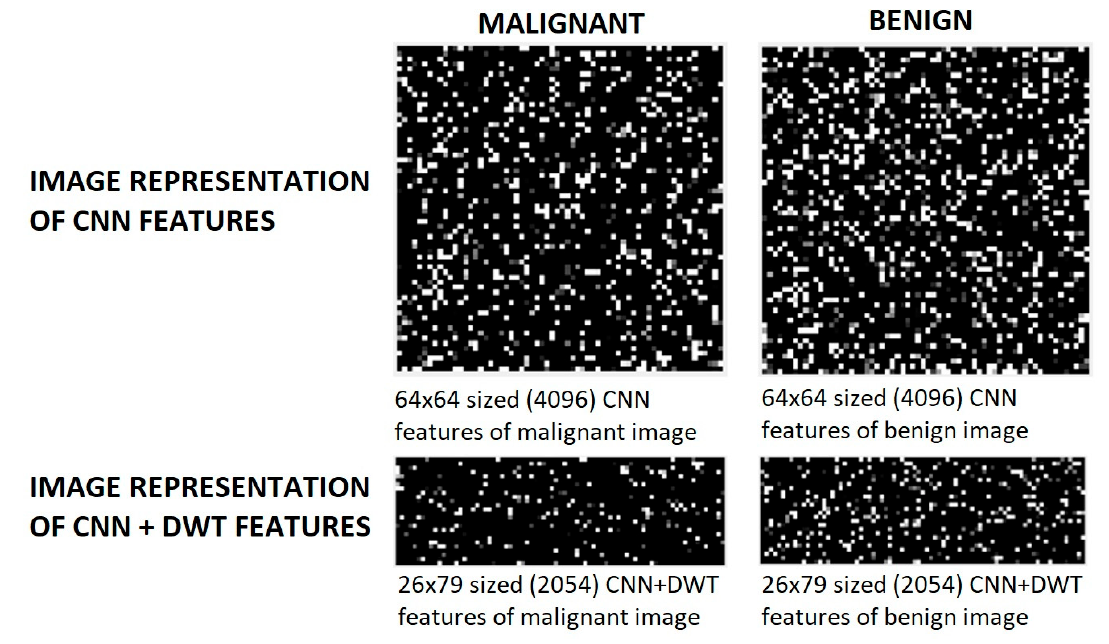
Figure 3. Image representation of CNN features of the liver images and image representation of cnn + dwt features that obtained from malignant and benign tumor images.